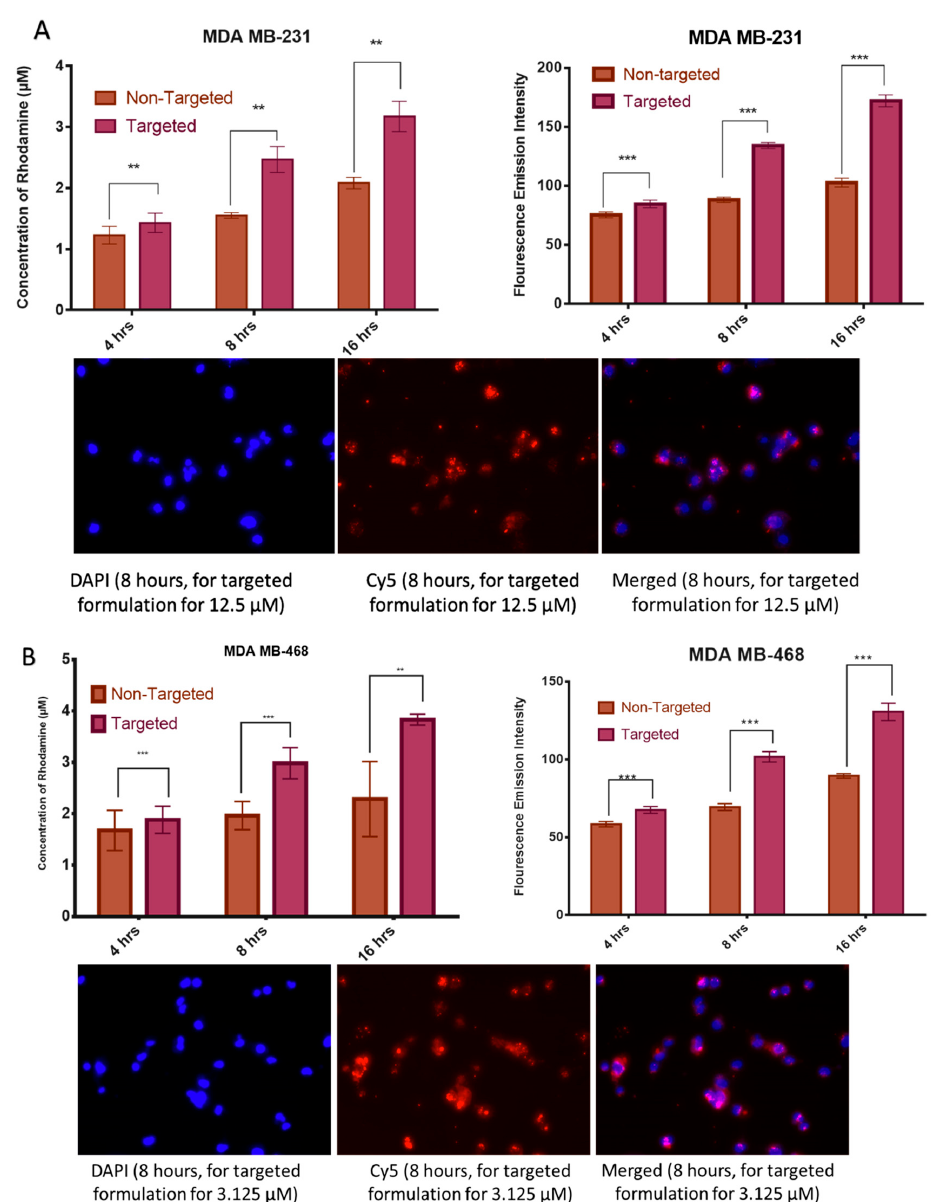
Figure 8. Fluorescence spectroscopic in ( A ) MDA-MB-231 and ( B ) MDA-MB-468 cell lines